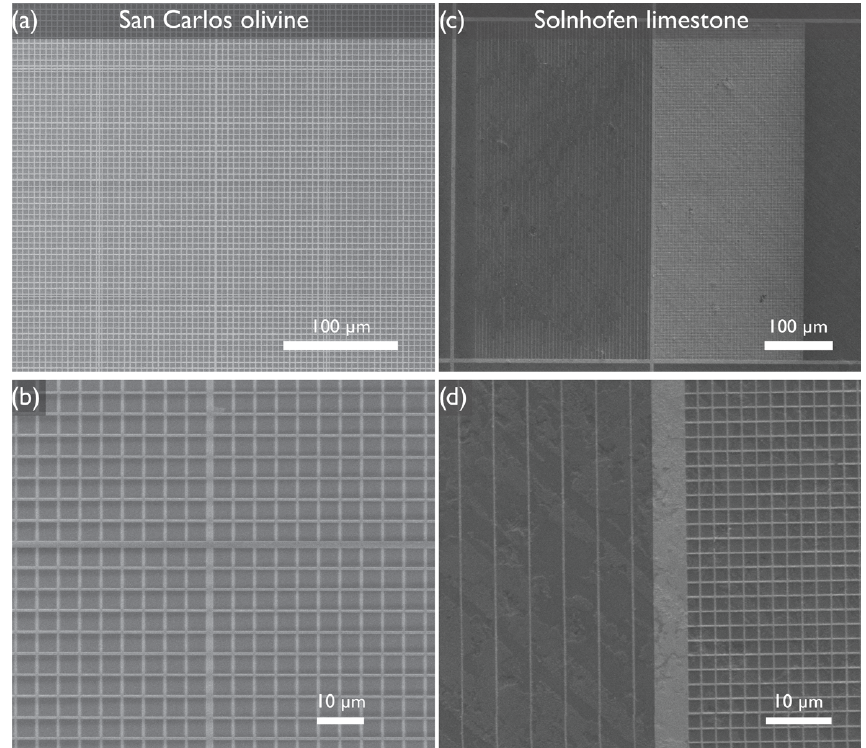
Figure 4. Secondary electron images of patterned San Carlos olivine (a, b) and Solnhofen limestone (c, d) . The grid in the San Carlos olivine sample is composed of 500µm lines spaced every 4.5µm (a) ; a zoom in is seen in panel (b) . For Solnhofen limestone, we combined 200nm straight lines with a regular grid of 200µm lines spaced every 2µm (c) ; a zoom into both areas is seen in panel (d)